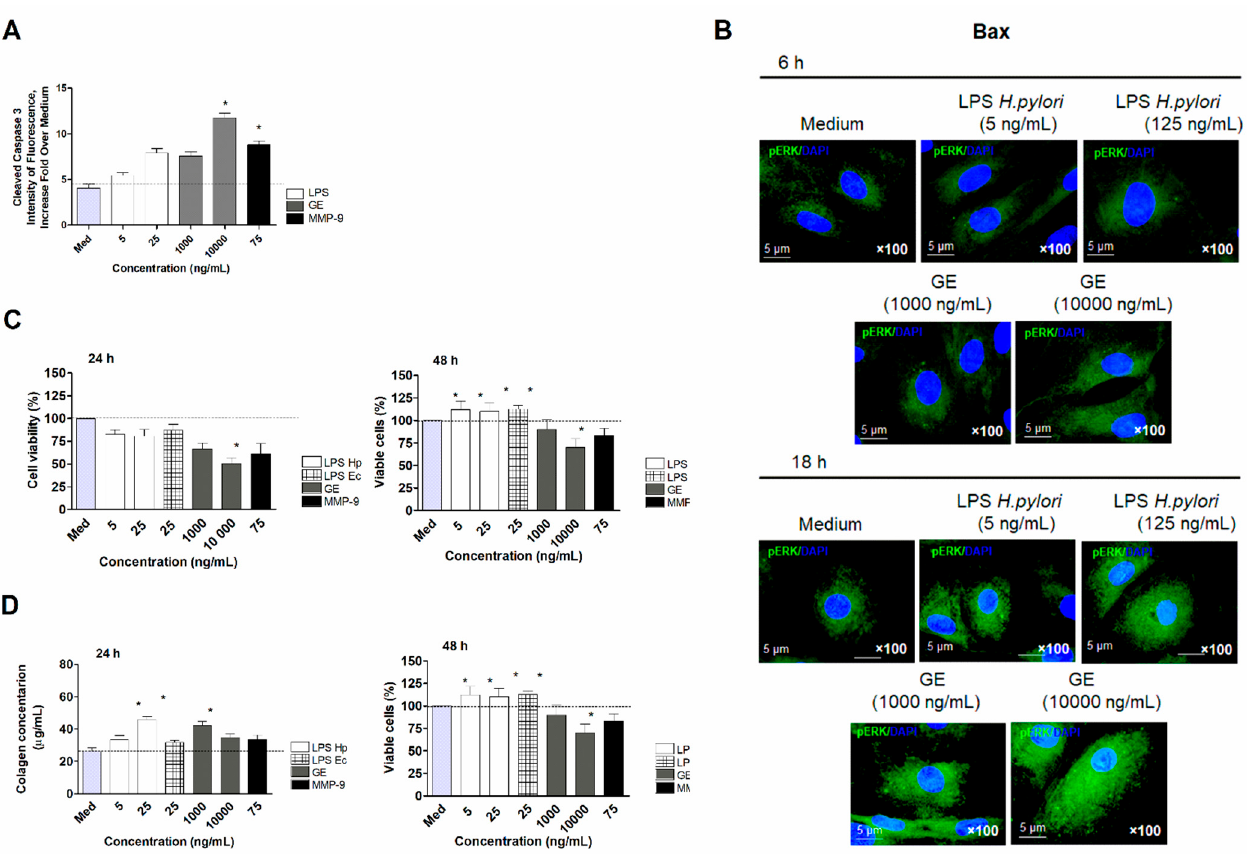
Figure 7. Detection of apoptosis intensity in vascular endothelial cells treated with H. pylori antigenic components: (GE) and lipopolysaccharide (LPS) or metalloproteinase (MMP)-9. ( A ) Cleavage of Caspase 3, presented as the intensity of the fluorescence fold increase across mediums. ( B ) Representative pictures of the expression of proapoptotic protein Bax in vascular endothelial cells analyzed with fluorescent microscopy at a 1000 × magnification. ( C ) Endothelial cell viability tested in an MTT reduction assay. Results are presented as the average percentage of cells (control and stimulated with H. pylori antigens). ( D ) The concentration of Collagen I in culture media of vascular endothelial cells (control or stimulated with H. pylori antigens). Data represent the average values of four independent experiments performed in triplicates for each experimental variant. Statistical analysis was performed using the nonparametric Mann–Whitney U test with significance for * p < 0.05 obtained for unstimulated cells vs. cells treated with stimulators.